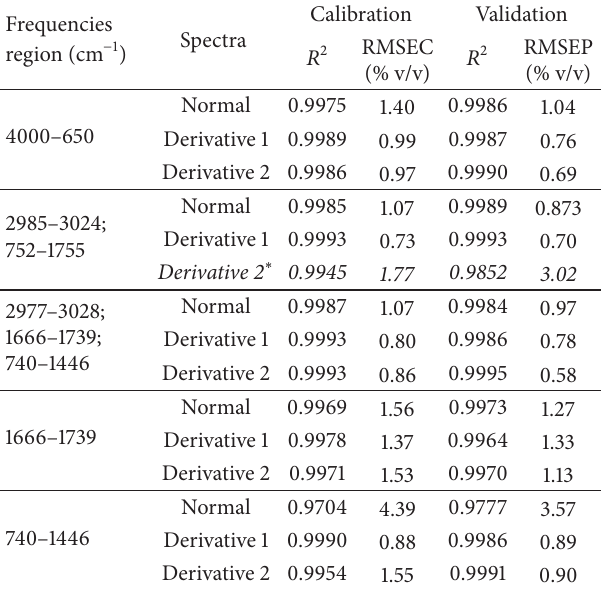
Table 5: PLS performances at some frequency regions for the determination of NSO in ternary mixtures with CO and